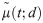
Average trading volume, μ˜(t;d)
v intraday time (minutes).The left panel is for 2S06 and the right panel for 1S13. In both cases we use different tones of blue to represent the morning and evening part of the sessions. The red line represent the numerical fit obtained for Eq (9). In both panels the volume is divided by 104.